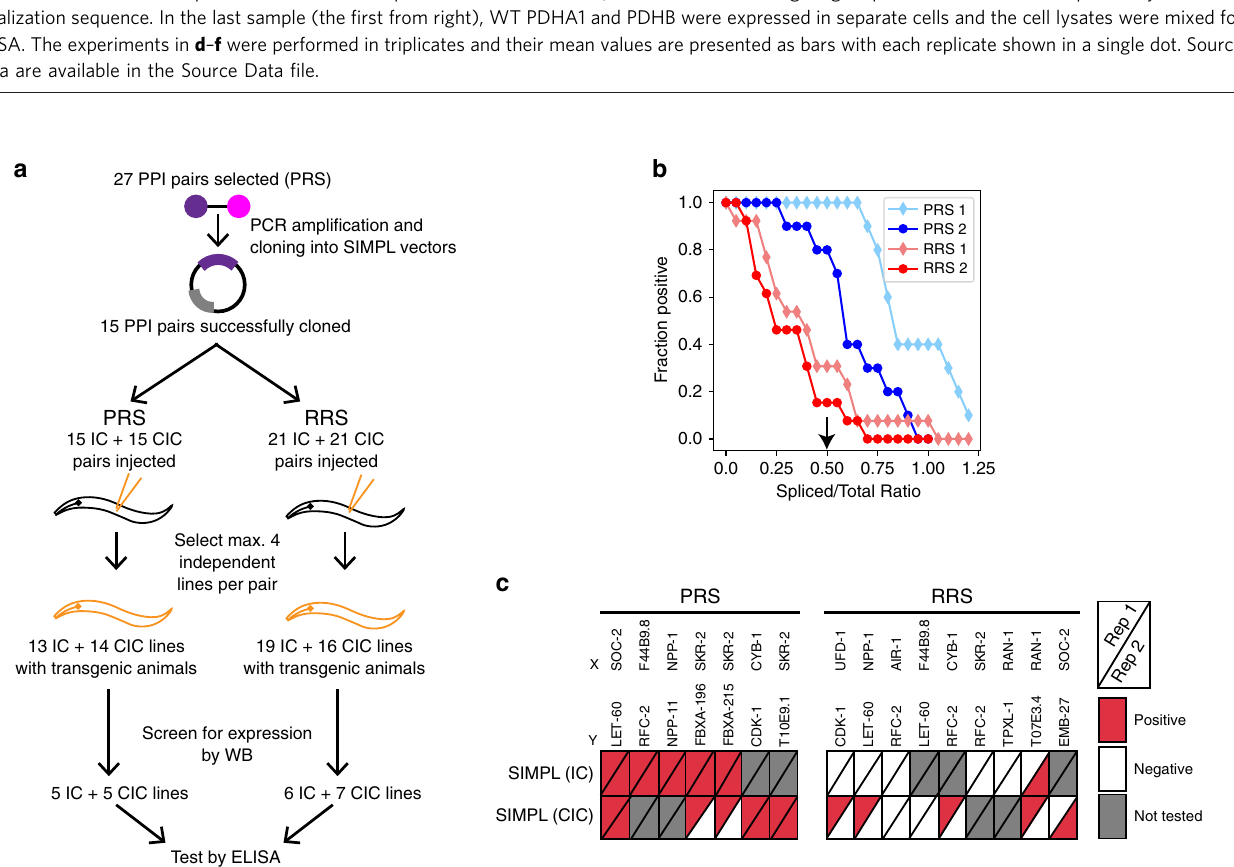
Fig. 5 Detecting PPIs in C. elegans with SIMPL. a Scheme for creating and testing transgenic C. elegans lines for use with the SIMPL ELISA assay. Initially, 15 positive reference set (PRS) PPI pairs were successfully cloned and injected into C. elegans , along with 21 random (RRS) PPI pairs, in both the IN/IC and IN/CIC con fi gurations (72 total lines injected). Potential transgenic lines were screened by western blot for expression of both bait and prey constructs, resulting in 10 total PRS lines and 13 total RRS lines (IC + CIC), representing 7 and 9 distinct PPI pairs, respectively. b Performance of the SIMPL ELISA assay in two biological replicates, with the fraction of PPI pairs that are positive at different cutoff values. Cutoffs were set as the ratio of spliced signal to total signal. A biological replicate was reported as the average value of two technical replicates. c Visualization of SIMPL ELISA results of the individually tested PPIs. The cutoff value used to determine whether a given PPI was positive or negative was 0.50 (arrow in b ), which maximized the number of true- positive and true-negative interactions between both biological replicates. Pairs belonging to the RRS were never positive in both replicates compared to the PRS. Source data are available in the Source Data fi